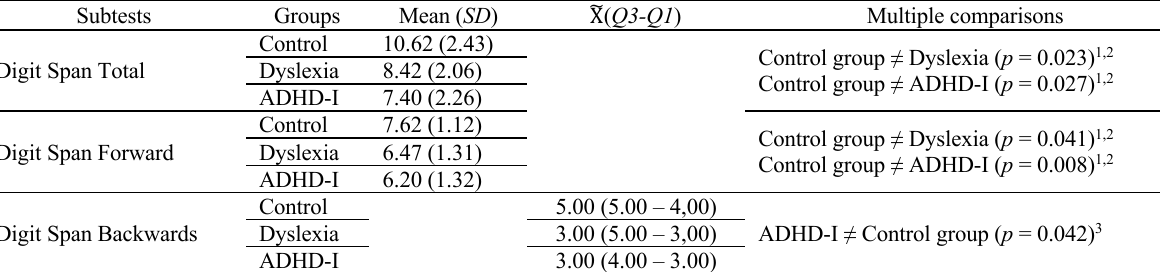
Table 4 – WISC-III digit span subtest